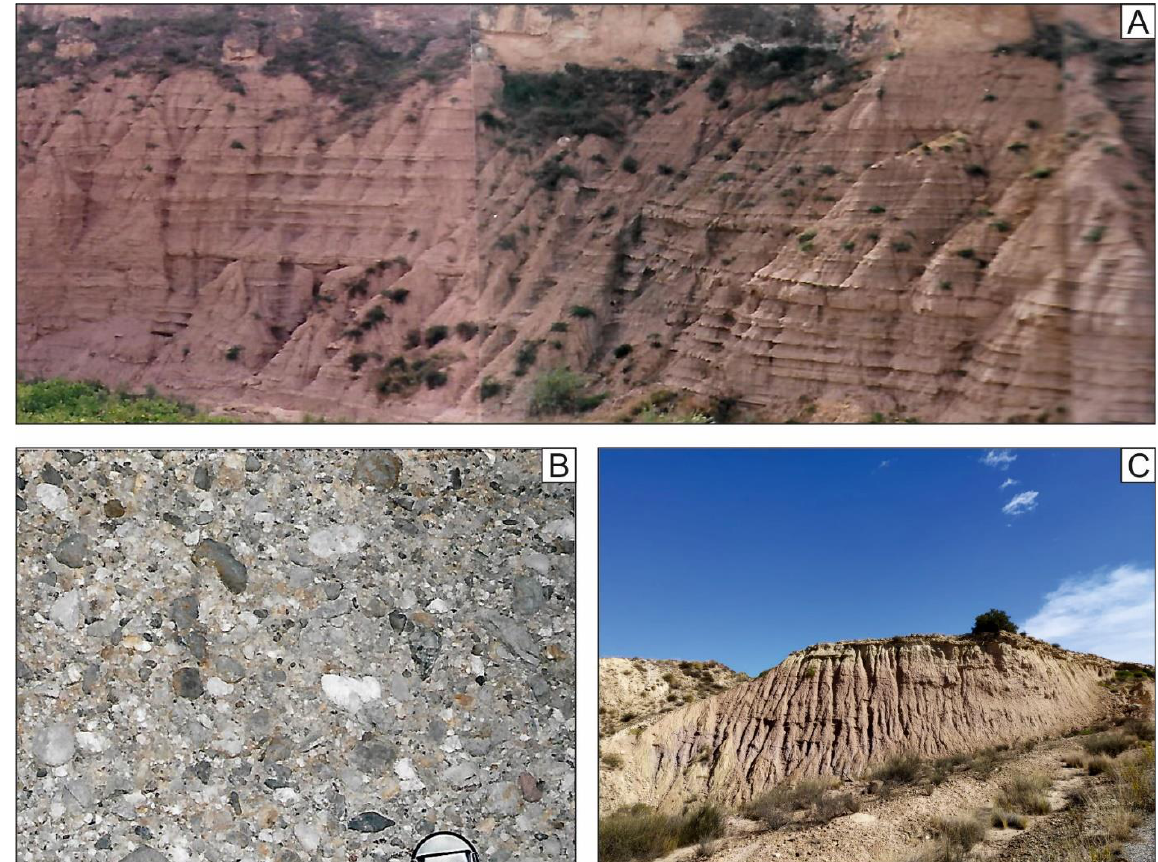
Figure 11. Site 7: The Upper Oligocene- Aquitanian Río Pliego Fm in the Mula area. ( A ) Panoramic view of the rhythmic succession of the Río Pliego Fm (reddish sandstones and pelites). ( B ) Detail of the polygenic conglomerates. ( C ) Detail reddish-yellowish pelites and marls.